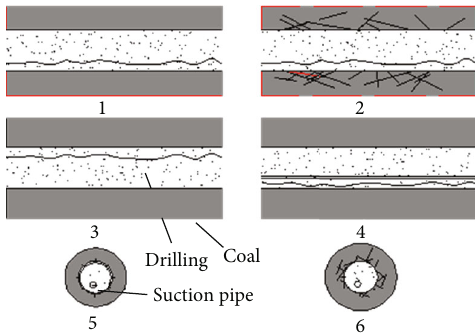
Figure 1: Reasons for air leakage in drilling. 1: air leakage from drilling cuttings; 2: air leakage from fi ssures; 3: air leakage from the upper part of the fi ller; 5: pressure relief ring around the hole; 6: rock movement creates new